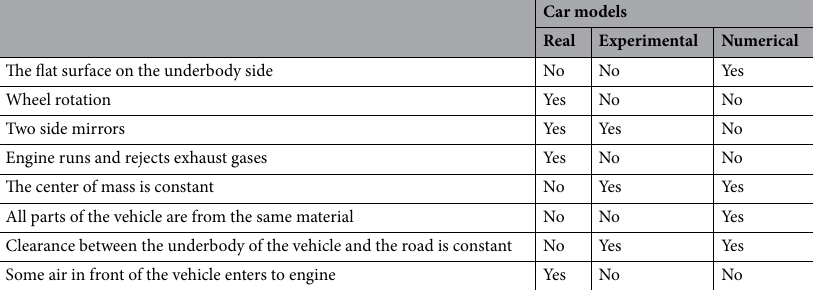
Table 1. The assumptions of the main conditions.